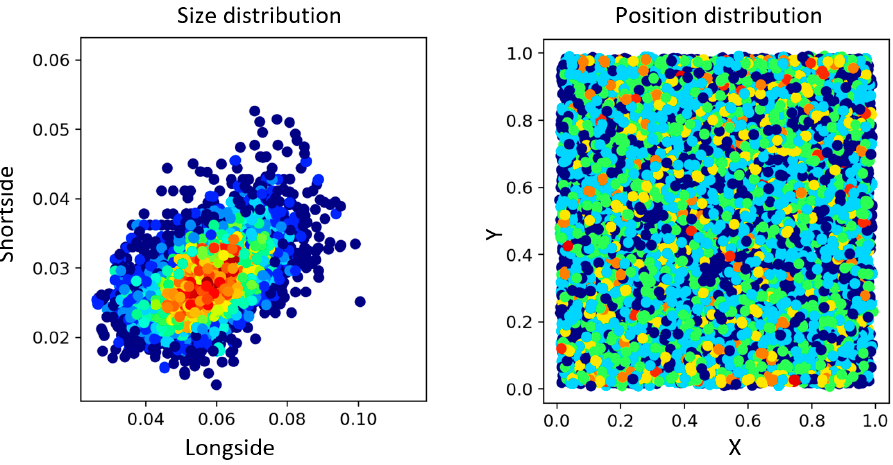
Figure 8. The schematic diagram of the bounding box distribution (RO-ARS).